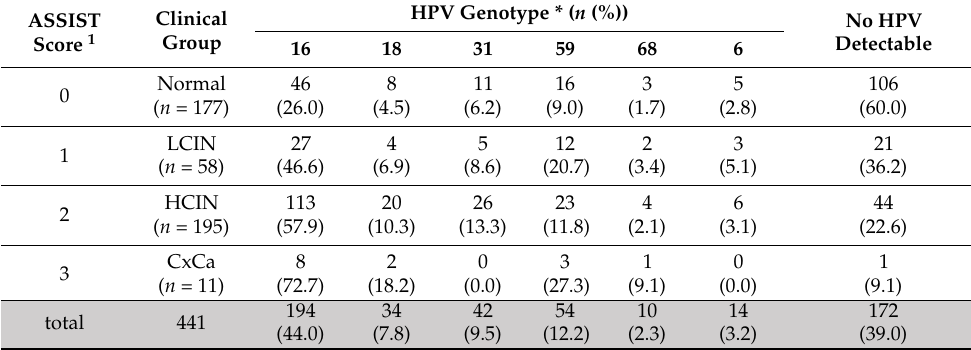
Table 3. HPV infections detected in clinical samples by QG-POC assay.